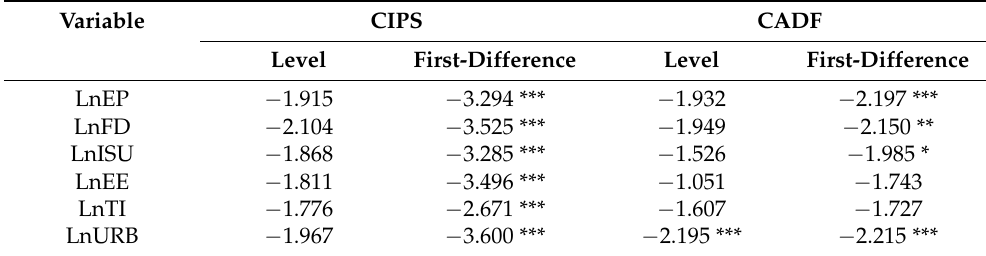
Table 4. Unit root test